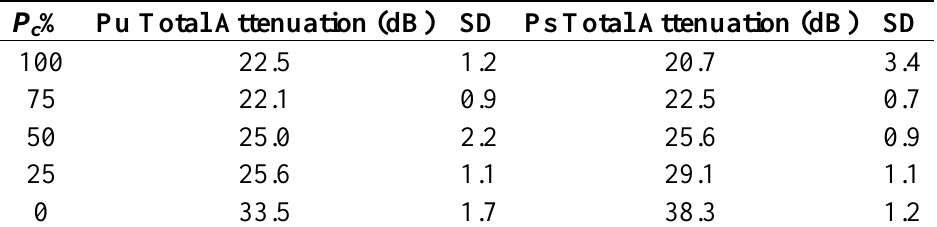
Table 3. Attenuation values and standard deviation for both (Pu and Ps) types of